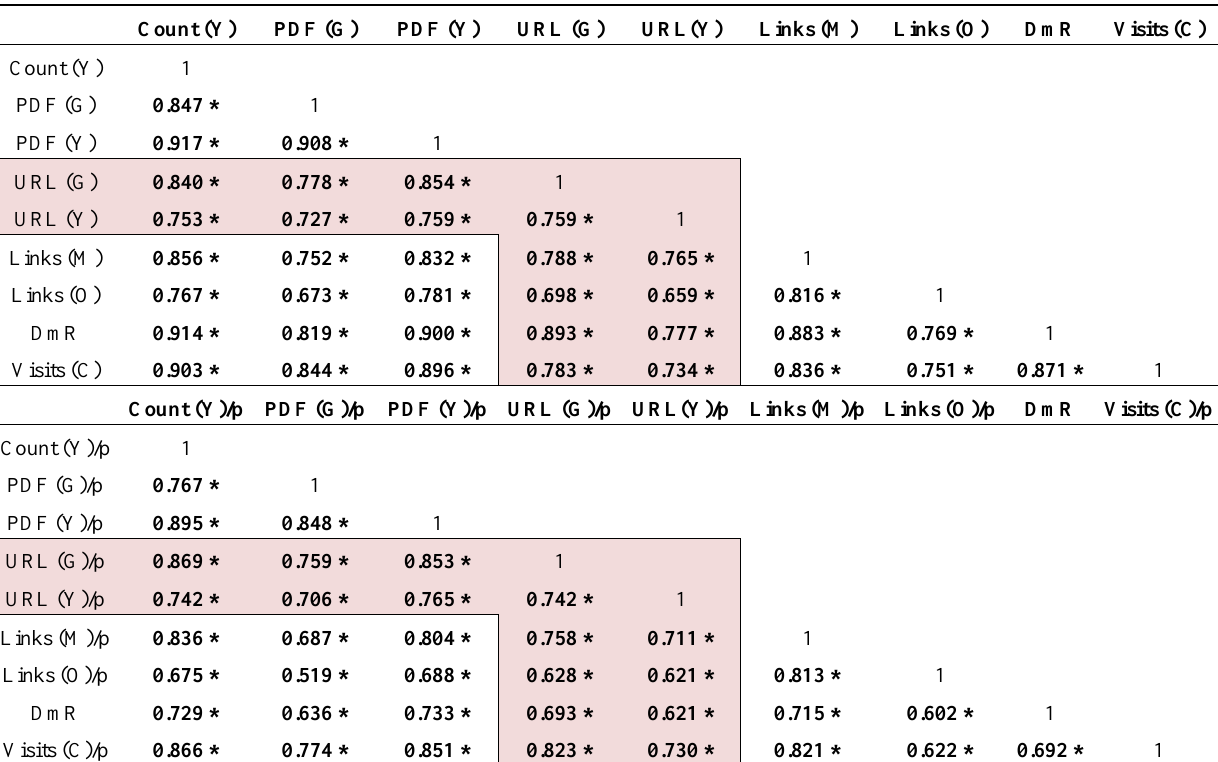
Table 3. Correlation among web data at university level (raw data and normalized by